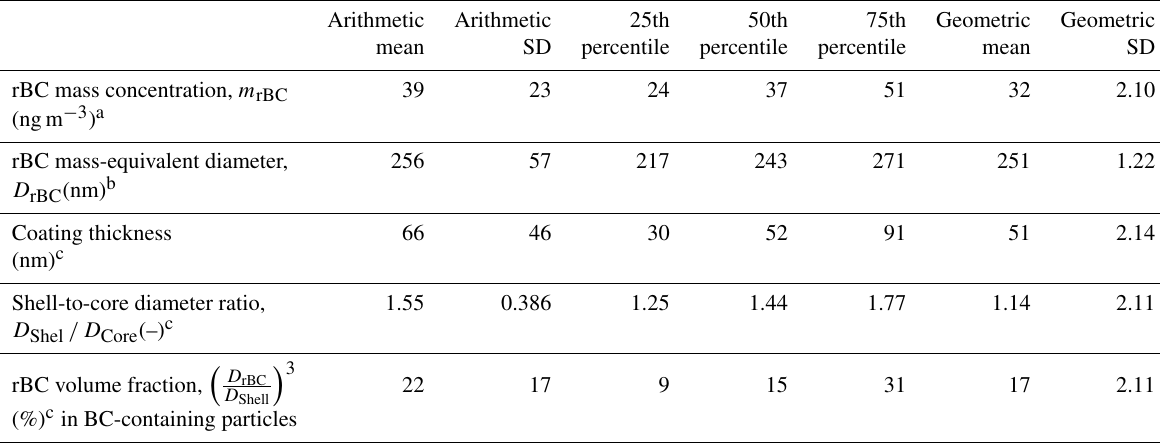
Table 2. Statistical analysis of black carbon particle properties for the full campaign. Arithmetic Arithmetic 25th 75th Geometric